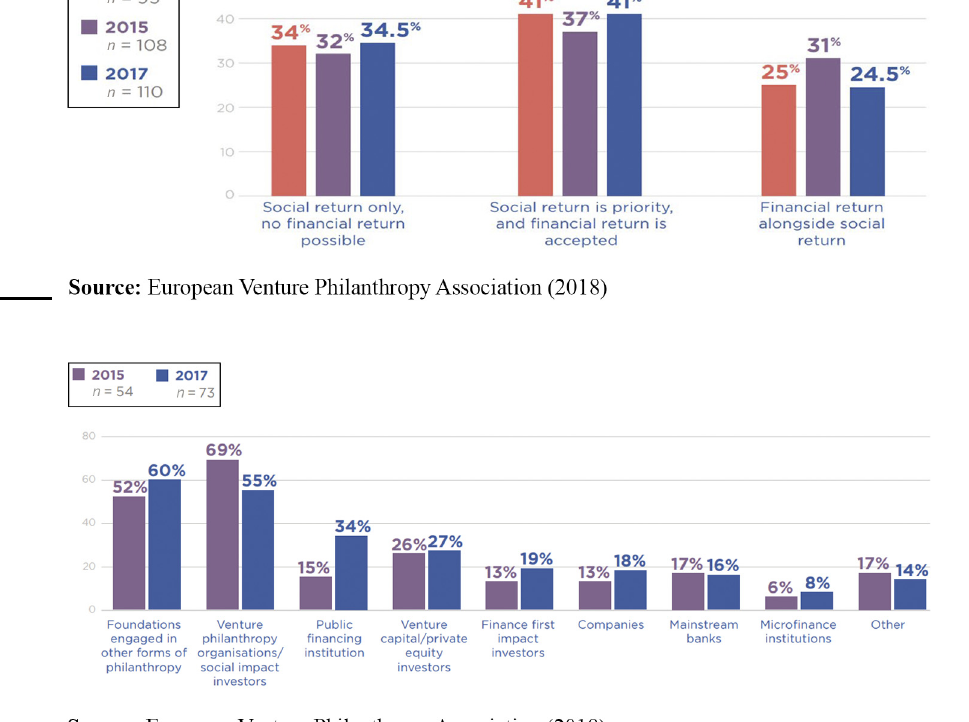
Figure 8. Who funds